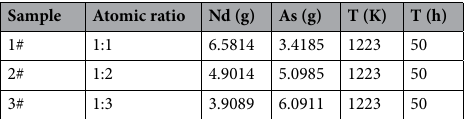
Table 1. Masses of Nd and As and the atomic ratio of Nd:As for sample preparation.